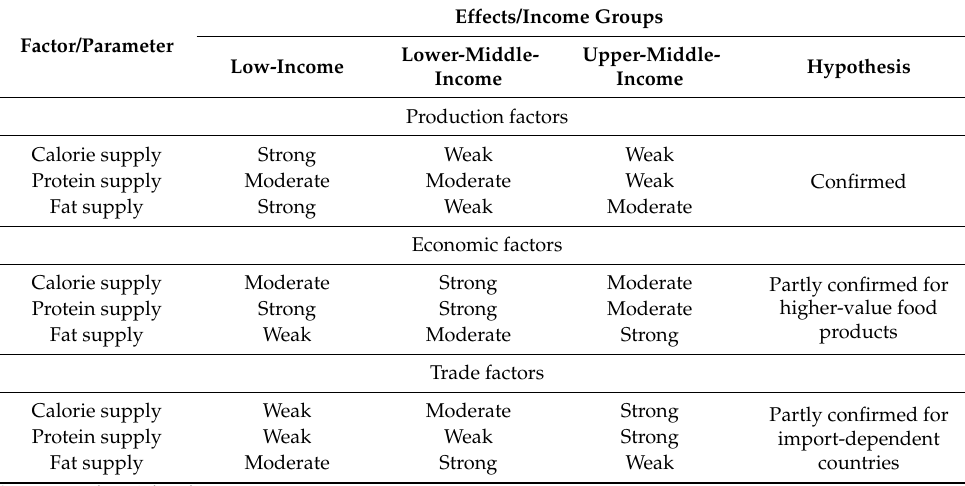
Table 10. Summary of production, economic, and trade effects on the supply of calories, proteins, and fats in the three income groups of countries in 1980–2018.